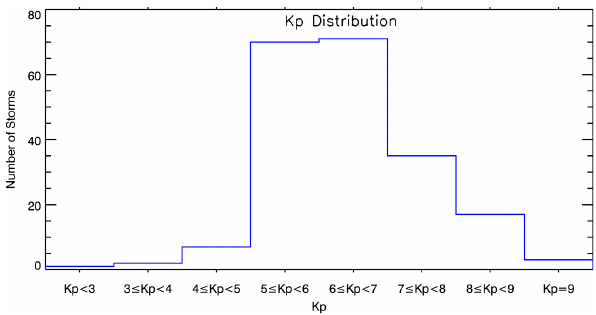
Fig. 10. The distribution of storms selected for this study accord- ing to the maximum value of the K p index during each of the 206 storm events. Three groups are formed with moderate storms ( K p ≤ 6) having 151 events ( ∼ 70%), strong storms ( K p =7) having 35 events ( ∼ 20%) and very strong storms ( K p =8–9) having 20 events ( ∼